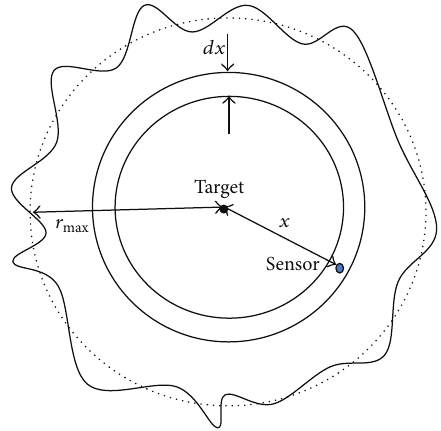
Figure 2: Impact of shadowed environment on